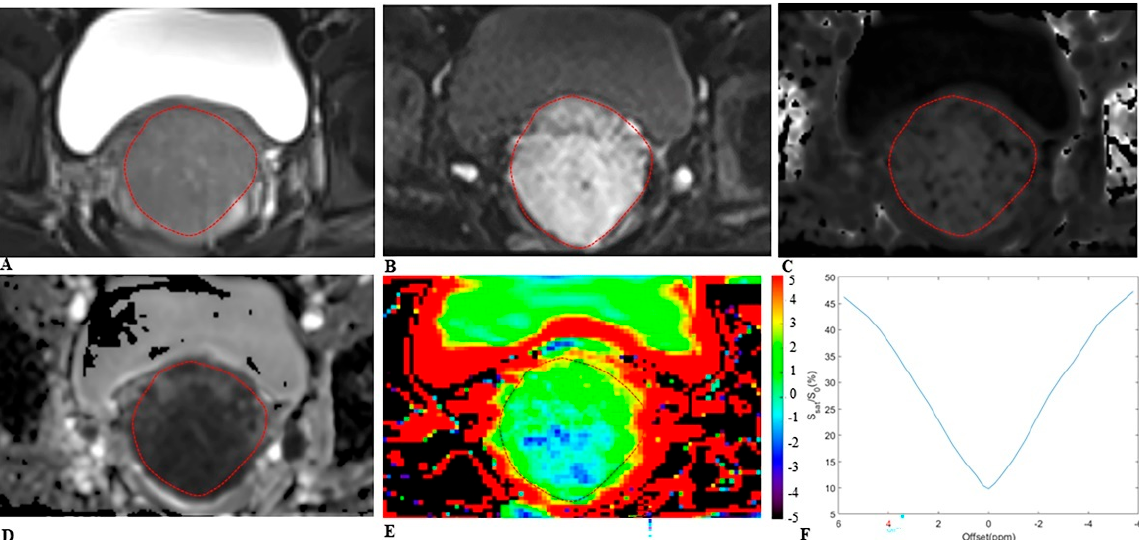
Figure 3. MRI scans in a 25 − year − old woman with cervical cancer and postoperative pathology revealed non − LNM. Axial ( A ) T2 − weighted image illustrates an exophytic tumor on the cervix wall. A diffusion − weighted image ( B ) with b = 1000 s/mm 2 shows a high − signal − intensity tumor. Mean kurtosis (MK) map ( C ) and mean diffusivity (MD) map ( D ) generated from DKI model. Amide proton transfer − weighted (APTw) image ( E ) and Z − spectrum of the tumor ( F ); the color bar indicates the APTw value. The mean MK, MD, and APTw values measured by the two radiologists were 0.832, 1.123 × 10 − 3 mm 2 /s, and 1.7%, respectively.